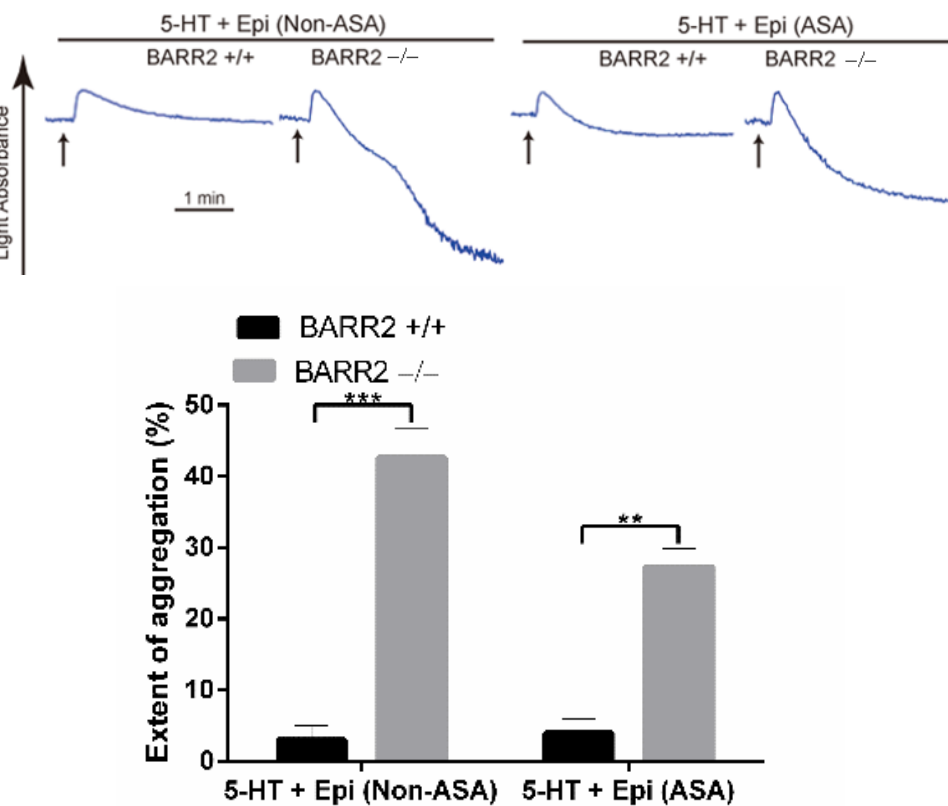
Figure 3. Arrestin3 regulates serotonin- and epinephrine-induced platelet aggregation. Non-aspirin (Non-ASA)- and aspirin (ASA)-treated washed platelets from WT (BARR2 +/+) and arrestin3 − / − (BARR2 − / − ) mice were stimulated with 20 µ M 5-HT + 100 µ M epinephrine, and platelet aggregation was assessed. Data are quantified and presented as mean ± SE **, p < 0.01; ***, p < 0.005. Three distinct experiments are represented in the tracings.